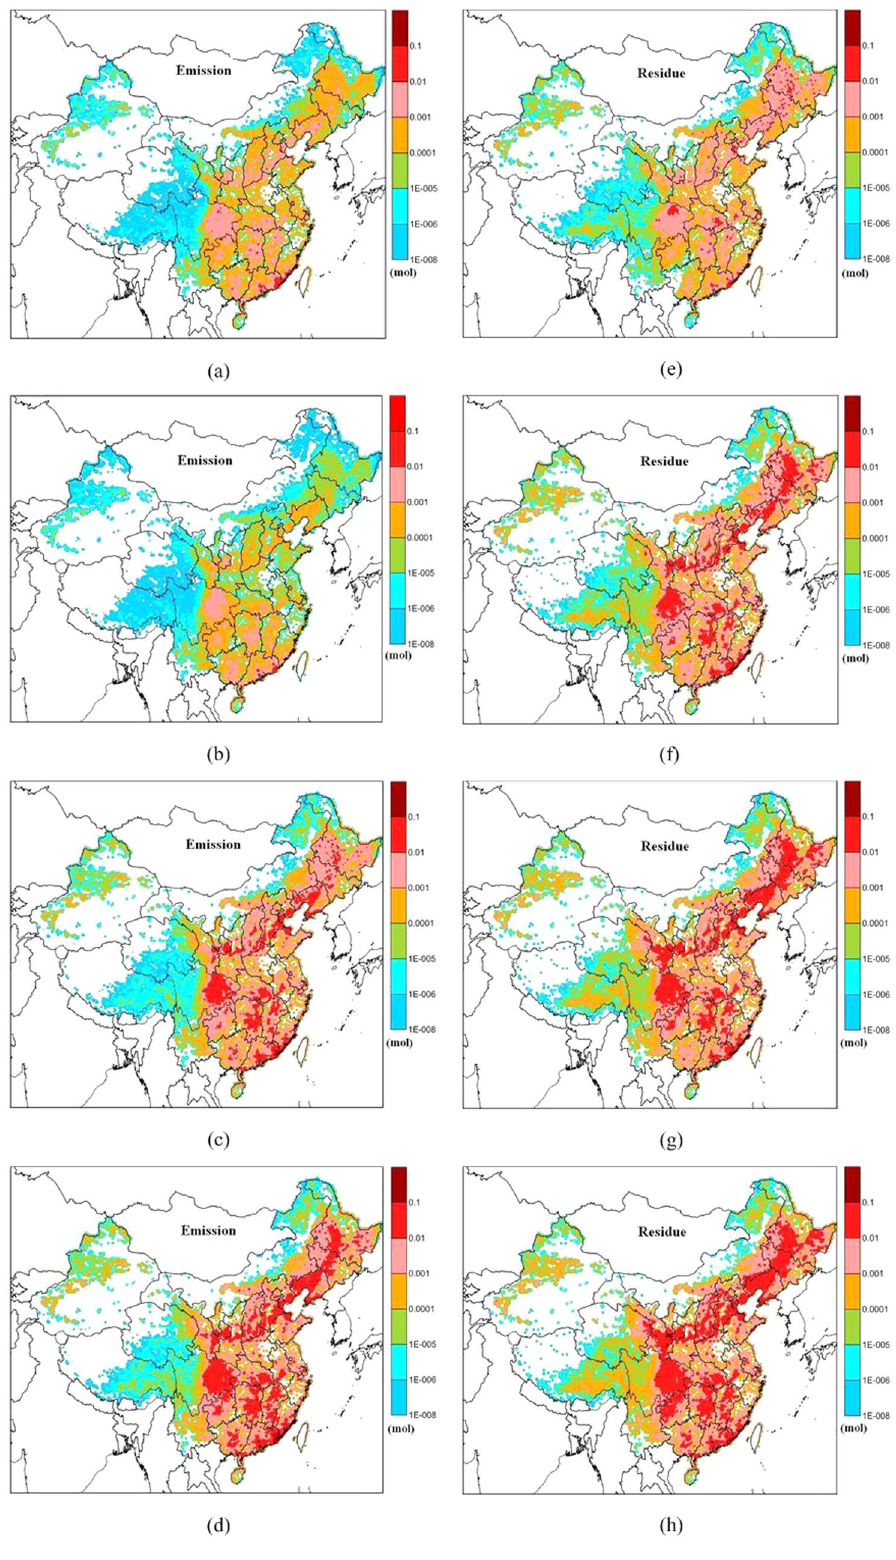
Figure 7. Spatial distribution patterns of cumulative emissions and residues for PCB28: ( a ) and ( e ) January; ( b and f ) April; ( c and g ) July; and ( d and h ) October in 2005 since 1965. The maps were drawn by the software of Surfer 9.0,